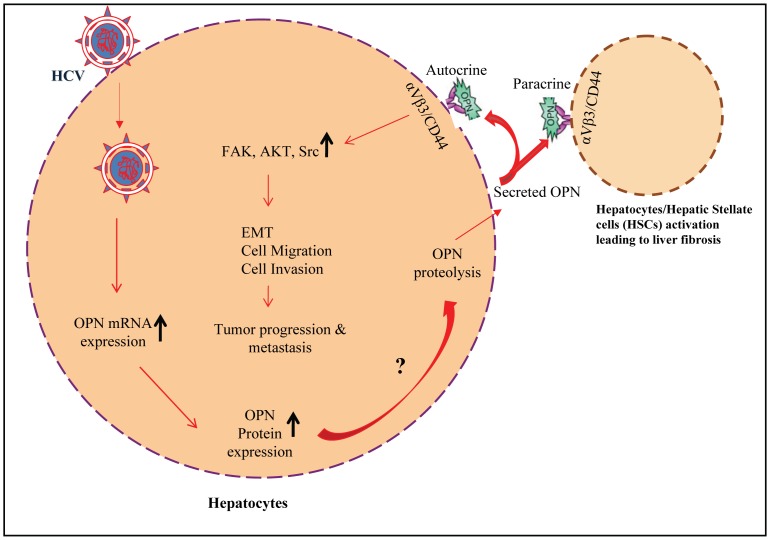

Model illustrating the OPN mediated signaling cascade in HCV-infected
                        hepatocytes.
HCV induces OPN expression, which is cleaved by unknown mechanism in response
                        to HCV-infection and the active forms are secreted out from the cells. The
                        secreted form of OPN binds to cell surface receptors on the same or other
                        cells via integrin αVβ3 and CD44. This interaction leads to
                        EMT, cell migration and invasion through the activation/phosphorylation of
                        FAK, Akt and Src mediated signaling pathways.